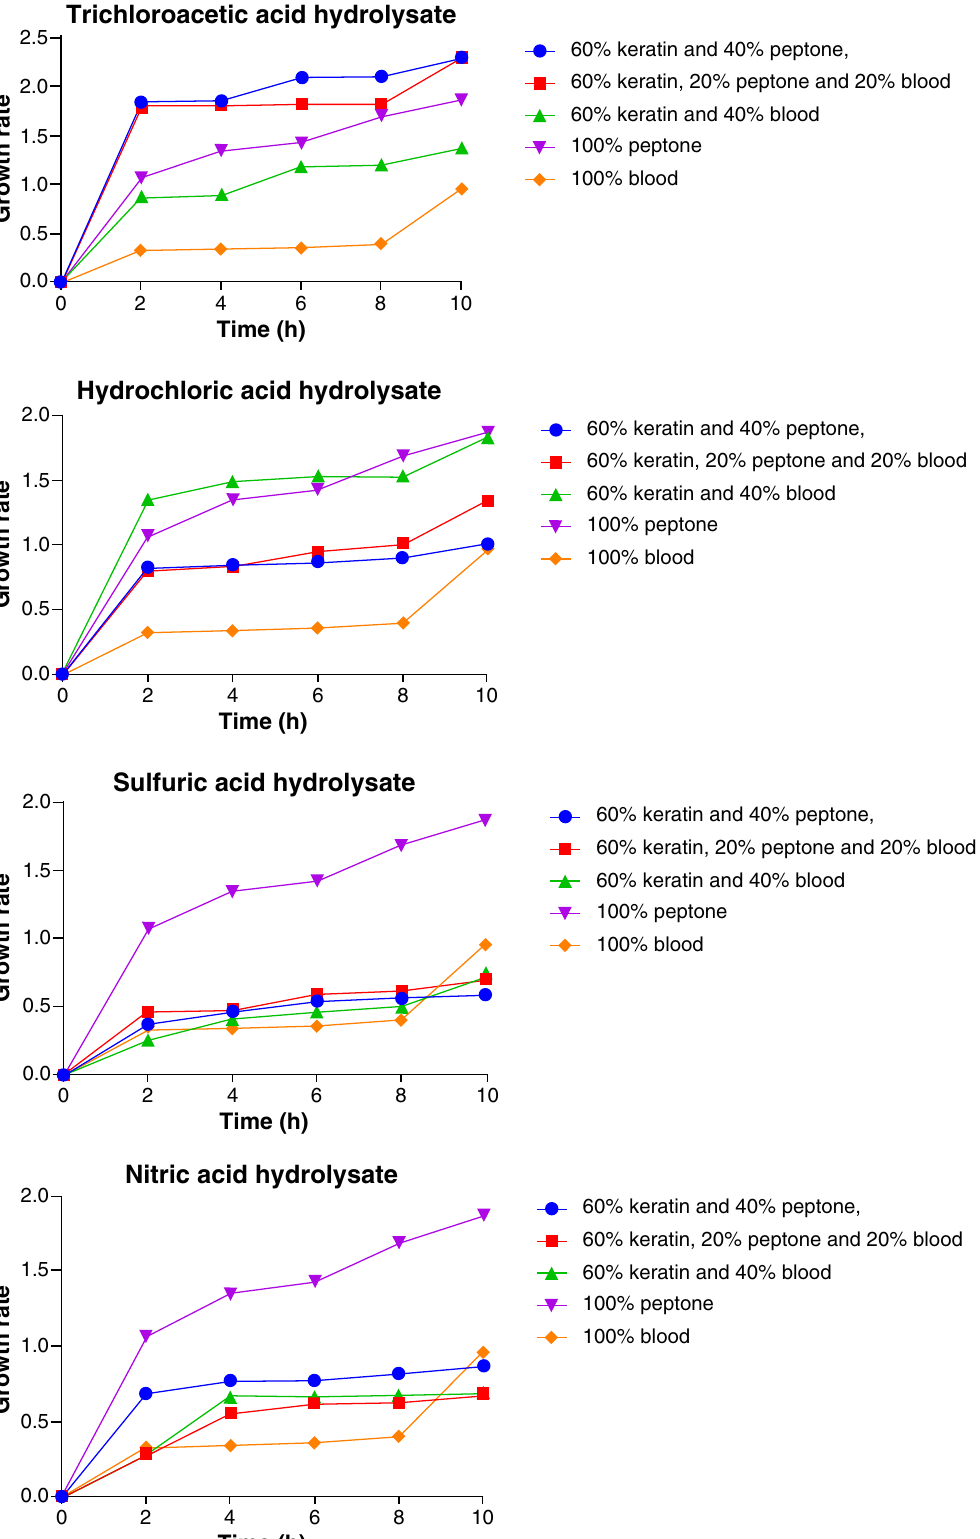
SO and HNO 2 4 3